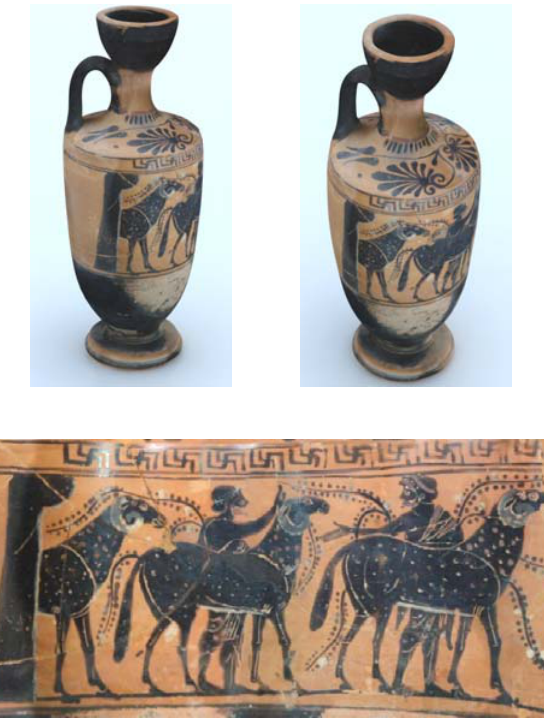
radiometric ig. 11. The final 3D model (up) and the development of the F texture map of the carving (bottom) of the bigger lekythos